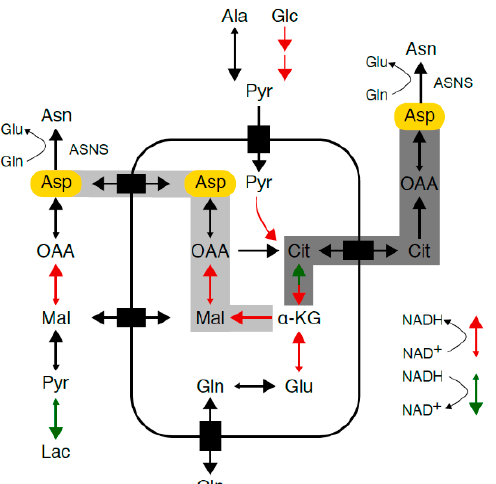
Figure 1. Asparagine synthesis. Mammalian cells maintain intracellular asparagine availability through import from the extracellular space and de novo synthesis from glutamine and aspartate (Asp, marked in yellow) through a unidirectional ATP-dependent reaction catalyzed by asparagine synthetase (ASNS). As aspartate transport into most mammalian cells is inefficient, aspartate supply depends on conversion of glutamine to glutamate to alpha-ketoglutarate, which enters the tricar- boxylic acid (TCA) cycle and is converted into aspartate via reductive carboxylation (marked in dark gray) or oxidative decarboxylation (marked in light gray). TCA cycle flux and glycolysis are accompanied by a continuous flow of electrons, during which nicotinamide adenine dinucleotide (NAD + ) serves as an electron carrier in a continuous cycle of reduction to nicotinamide adenine dinucleotide hydride (NADH) (marked in red) and oxidation back to NAD + (marked in green).